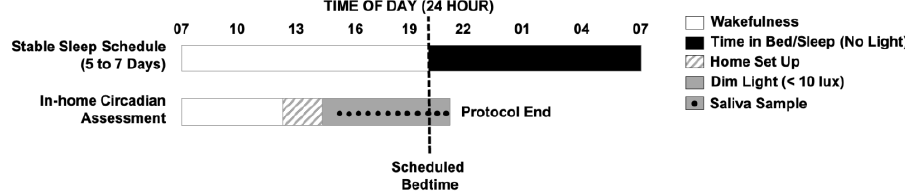
Figure 1. Protocol to assess DLMO. For 5 to 7 days, children follow their habitual parent-selected sleep schedule. On the day of the circadian assessment, children enter a dim-light environment 5 h and 30 min before bedtime (< 10 lux). They provide saliva samples throughout the evening at 30 min intervals until 1 h past their habitual bedtime (12 samples). The times depicted are meant as an example of a parent-selected sleep schedule and associated protocol times for an individual child participant.